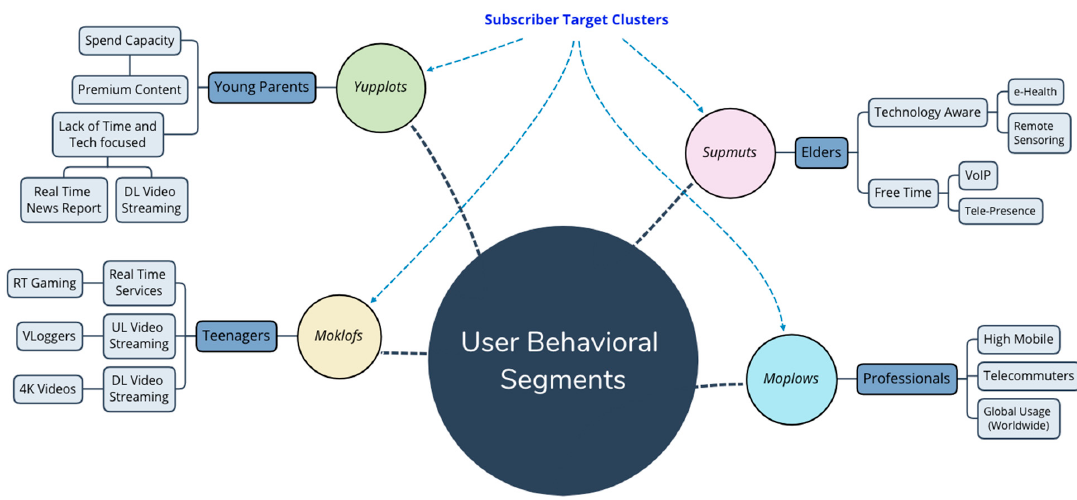
Figure 2. User behavioral clusters and resumed characteristics: Real Time (RT), Downlink (DL), Uplink (UL), Voice over IP (VoIP).